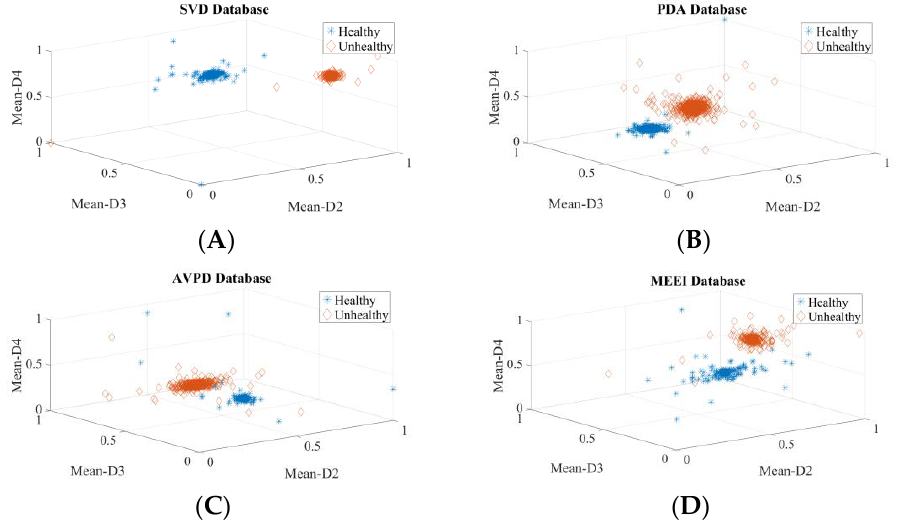
Figure 9. Scatter plots of three most common descriptors for pathology identification process: ( A ) Scatter plot of top three descriptors of SVD, ( B ) Scatter plot of top three descriptors of PDA, ( C ) Scatter plot of top three descriptors of AVPD, ( D ) Scatter plot of top three descriptors of MEEI.